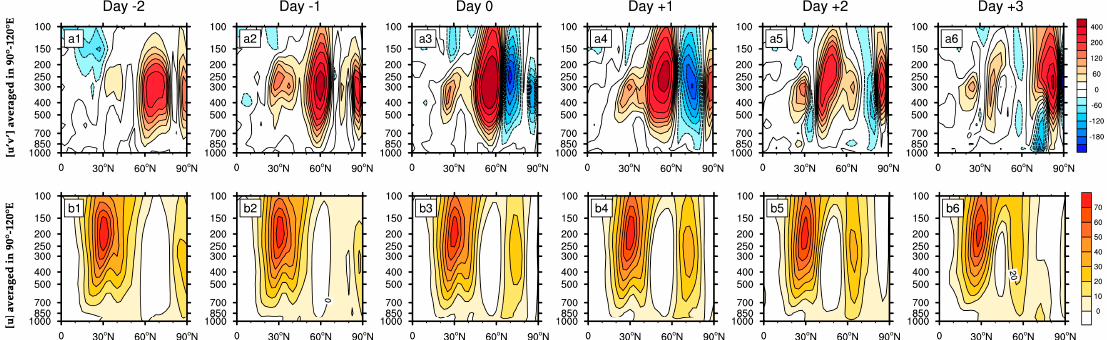
Figure 3. Pressure-latitude cross section in blocking high areas of the mean [ u (cid:48) v (cid:48) ] (unit: m 2 · s − 2 ) and zonal wind ([ u ]) (unit: m · s − 1 ). (a1–a6, b1–b6 indicate the [ u (cid:48) v (cid:48) ] (unit: m 2 · s − 2 ) and [ u ] (unit: m · s − 1 ) averaged in 90 ◦ –120 ◦ E from January 19 to 24 in 2016, respectively.)